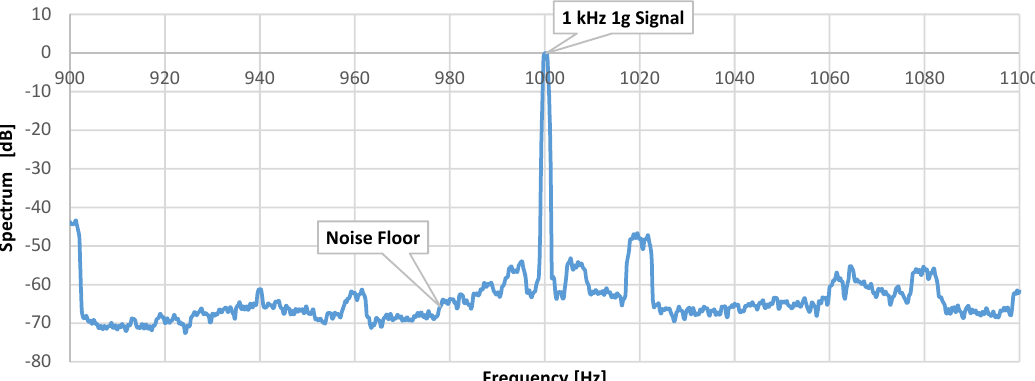
Figure 13. The output noise spectrum.